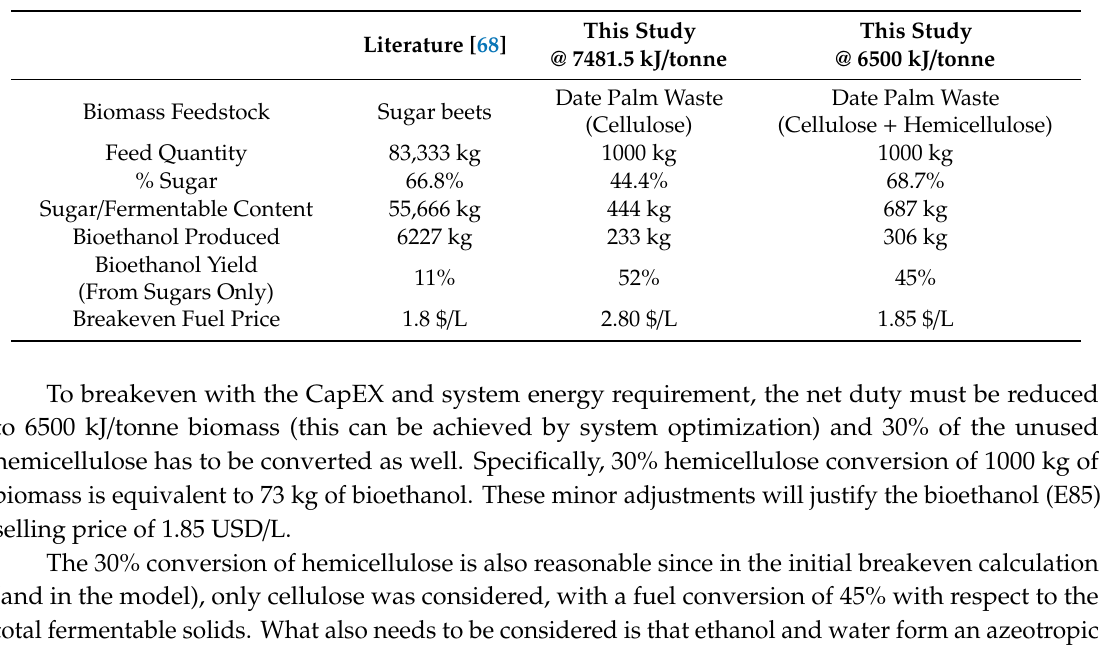
Table 8. Checking fermentation economic